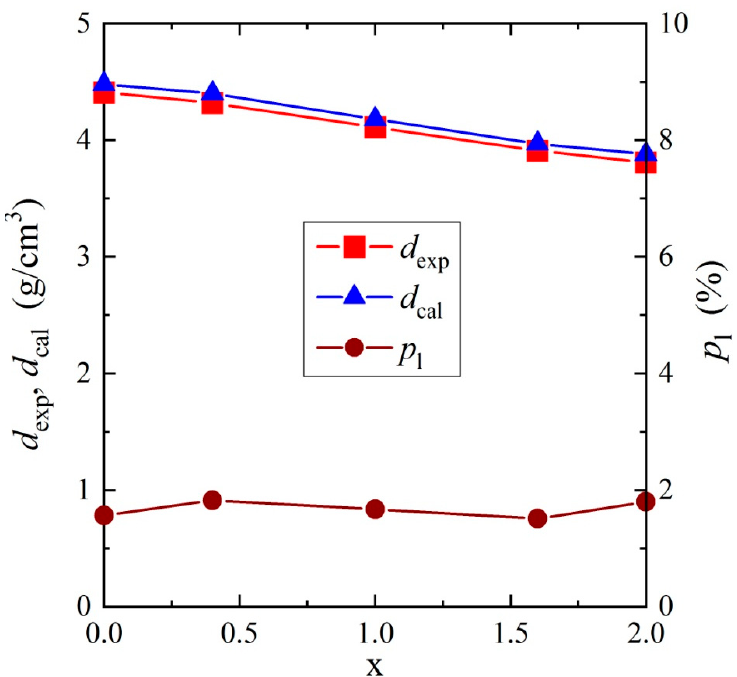
Figure 2. Experimental, d exp , and calculated, d cal , solid-state density and porosity level, p l , as a function of the content x of Zn 2 − x Mg x InV 3 O 11 . Calculated data is taken from Bosacka and Filipek [10].